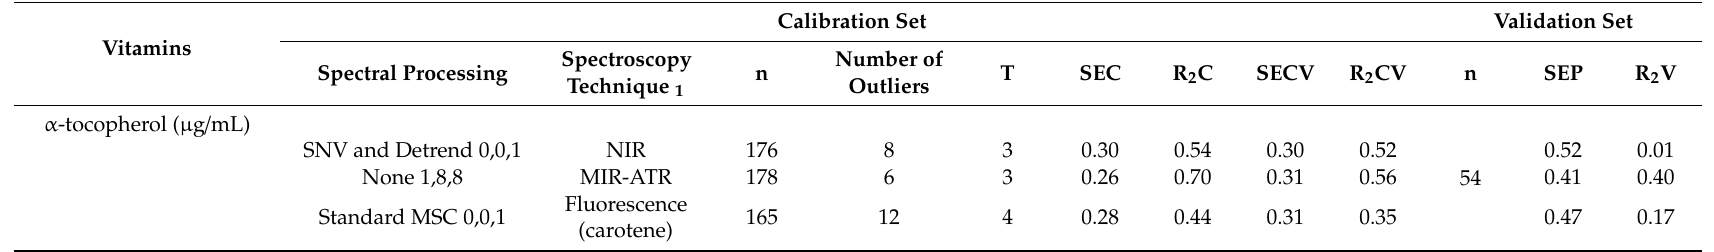
Table 4. Prediction of di ff erent vitamins in cow milk according to the equations developed from three spectroscopy techniques: near-, mid-infrared (NIR and MIR, respectively) and fluorescence